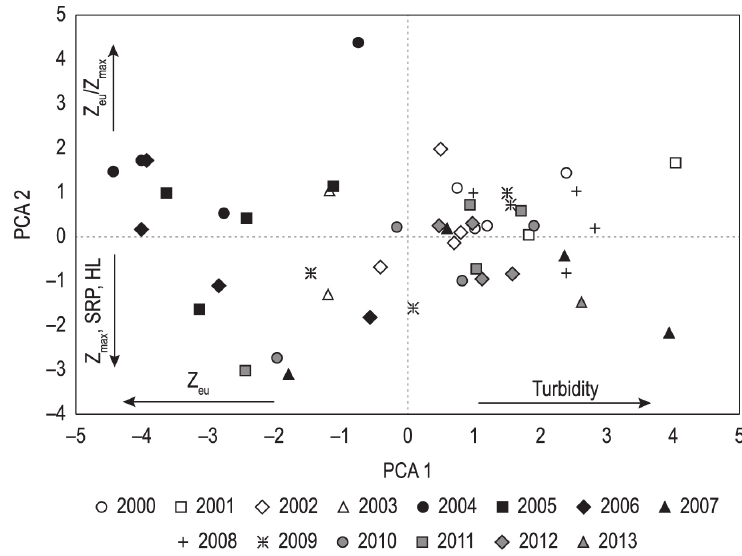
Figure 3. Ordination showing the variables most correlated to the first two axes of a Principal Components Analysis for floodplain Lake. (See legends in Methods).